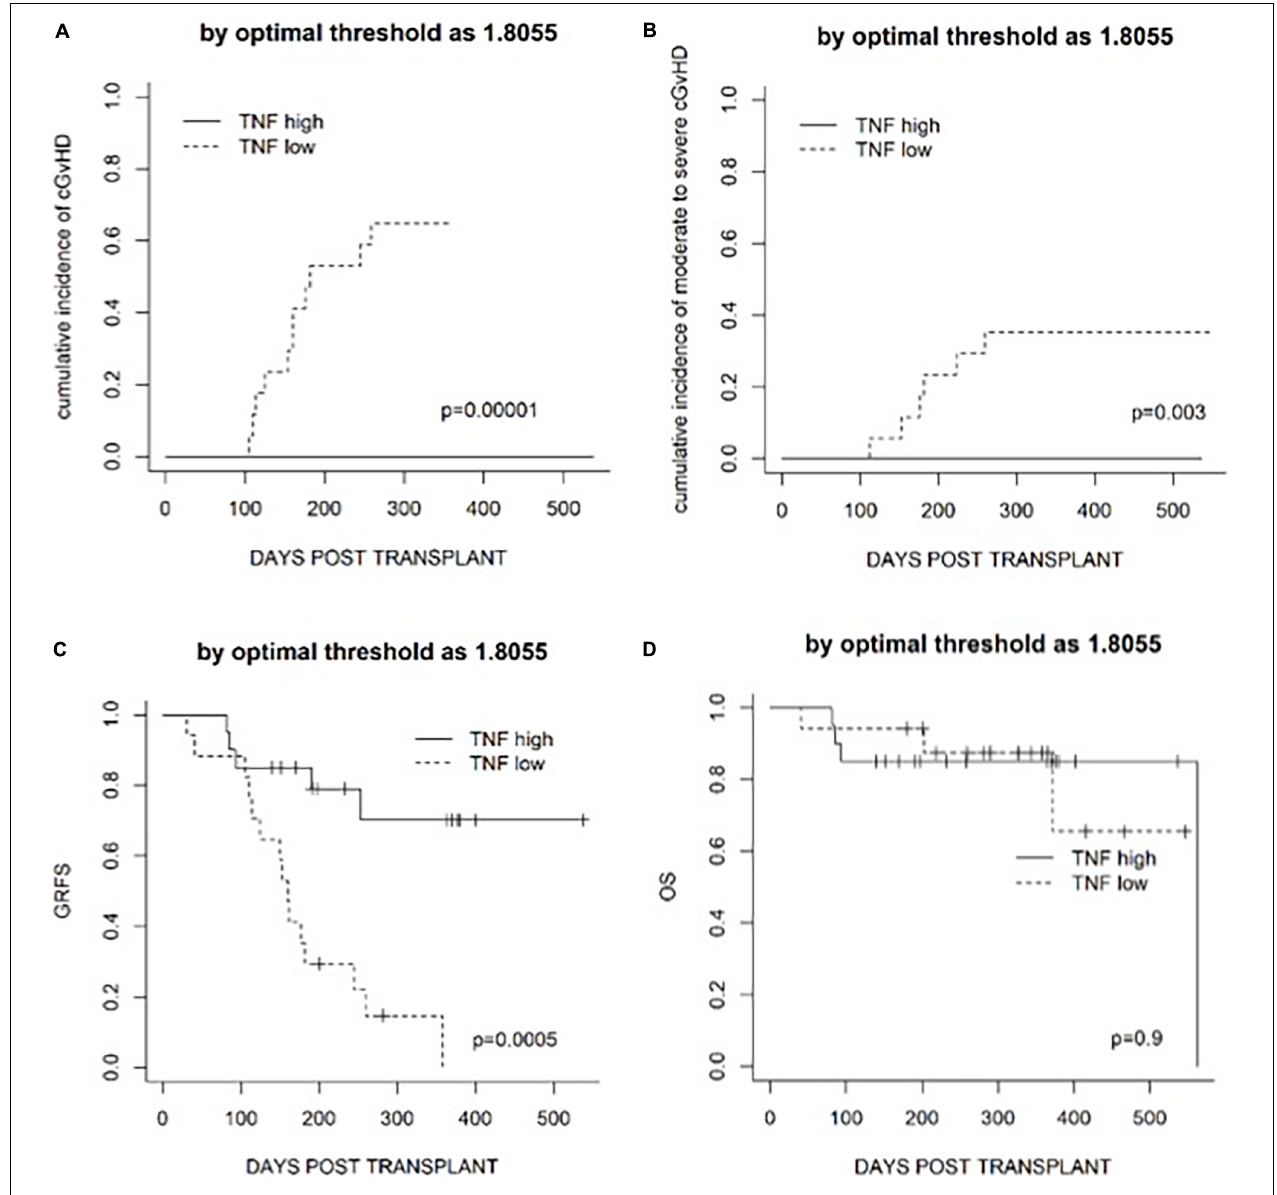
FIGURE 5 | Transplantation outcomes in patients classified according to the optimal threshold defined by an ROC curve analysis. (A) The cumulative incidence of cGvHD. (B) The cumulative incidence of moderate to severe cGvHD. (C) GRFS. (D) Overall survival